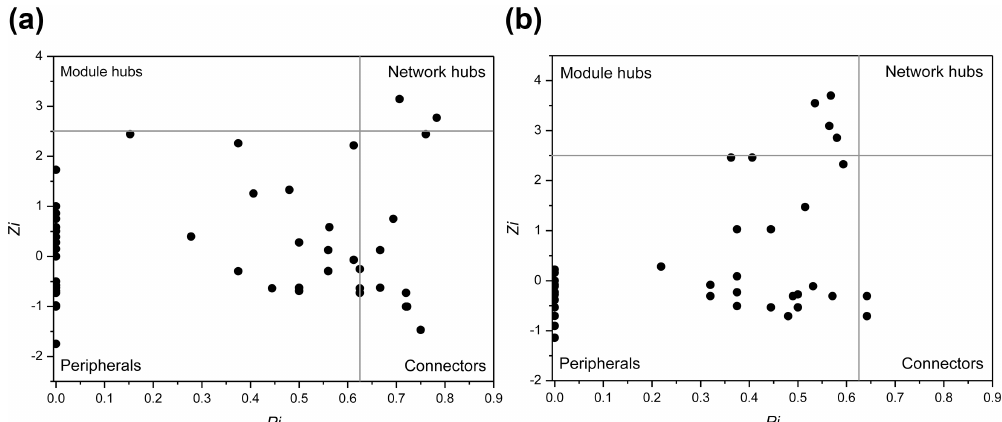
Figure 5. Sub-modules in ecological network analysis under LC (a) and HC (b) conditions. Each dot represents an OTU. The Z − P plot shows OTU distribution based on their module-based topological role according to within-module ( Z) and among-module ( P) connectivity. The nodes were defined as module hubs with Zi>2.5 and Pi<0.625, which were more closely connected within the module, while the connectors with nodes Zi<2.5 and Pi>0.625 were more closely connected to nodes in other modules. Network hubs are super-generalist with a Zi>2.5 and Pi>0.625. The other nodes were considered